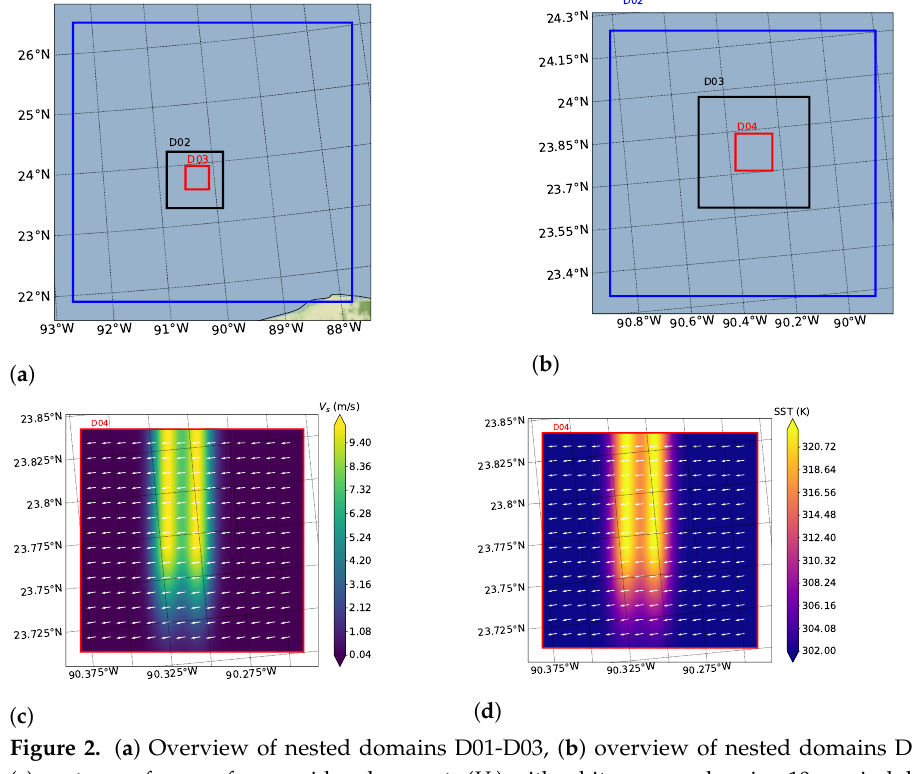
Figure 2. ( a ) Overview of nested domains D01-D03, ( b ) overview of nested domains D02–D03, ( c ) contours of sea surface meridonal currents ( V s ) with white arrows showing 10 m wind direction, and ( d ) contours of sea surface temperature